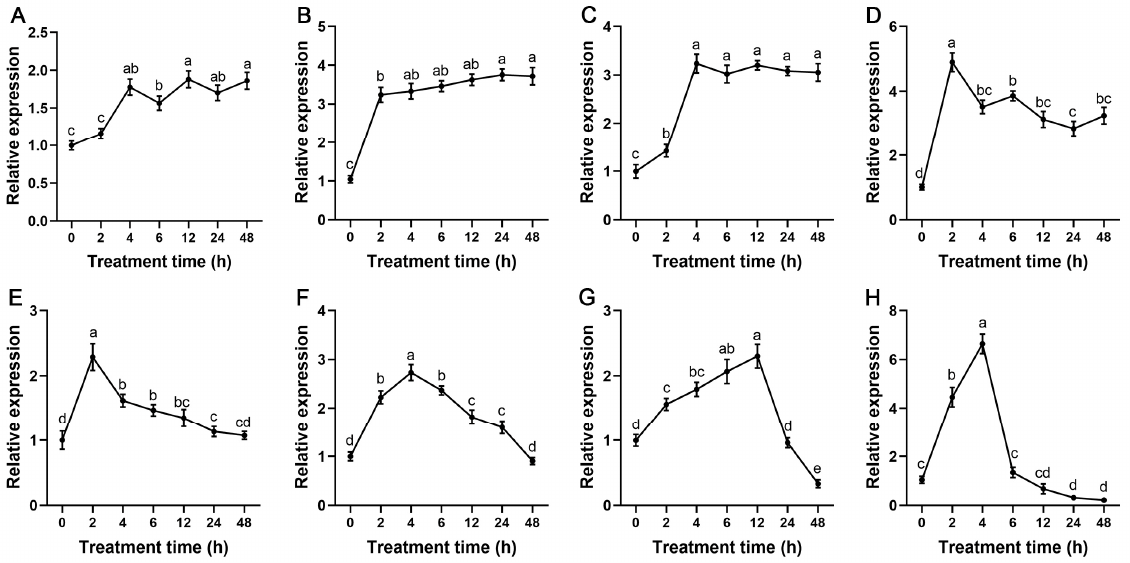
Figure 7. The relative expression level of StSnRK2 genes under 50 µM ABA stress treatments. Data represent the means ± SD of three replicates, and different letters indicate significant differences at p < 0.05. ( A – H ) StSnRK2.1 – StSnRK2.8 , respectively.